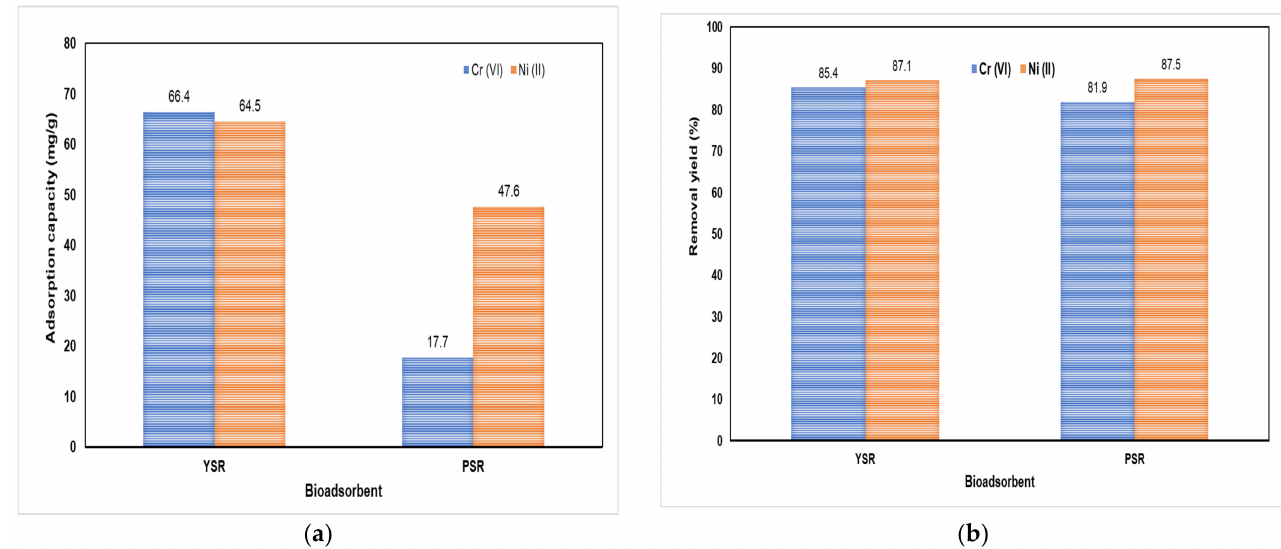
Figure 5. Results of Cr (VI) and Ni (II) adsorption on biomass-derived adsorbents. n = 1. ( a ) Adsorption capacity; ( b ) Removal efficiency. Table 7. Best adsorption conditions for Cr (IV) and Ni (II) on YSR and PSR.